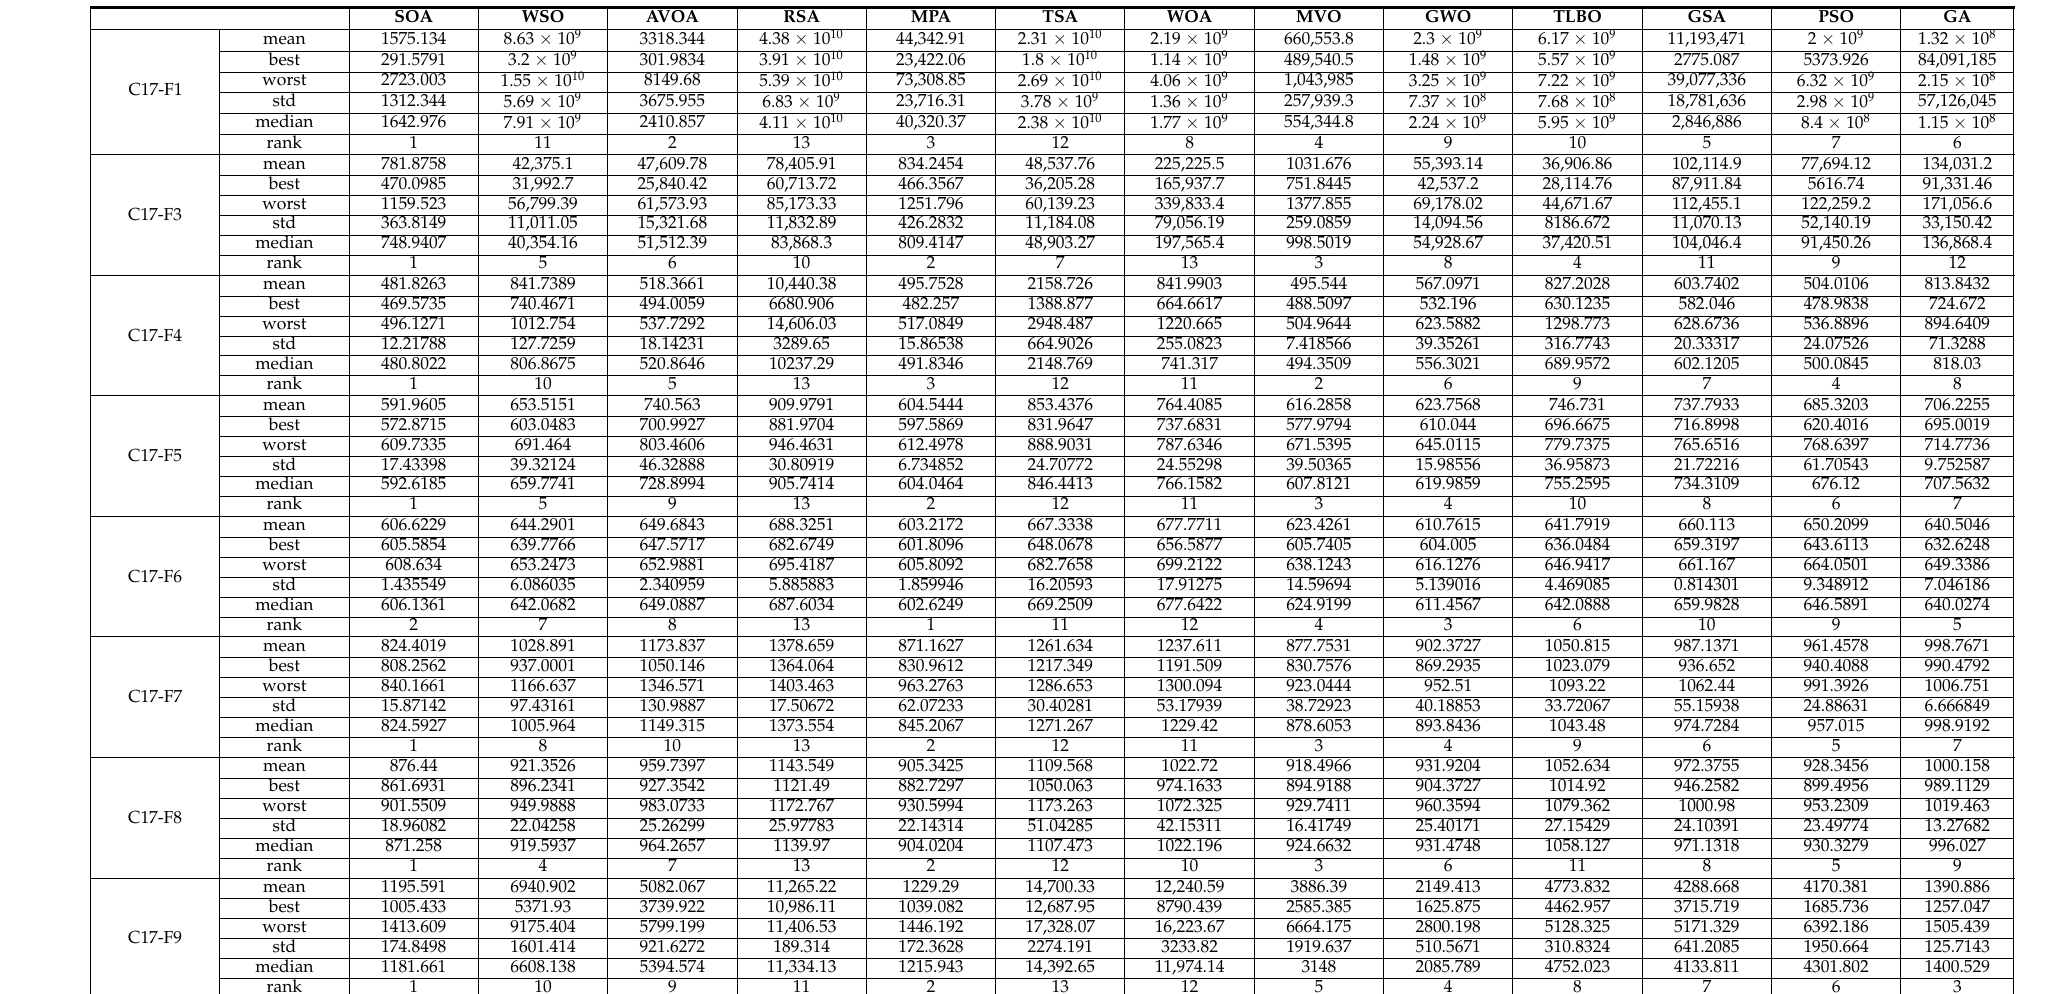
Table 3. Optimization results of the CEC 2017 test suite (for the dimension d =